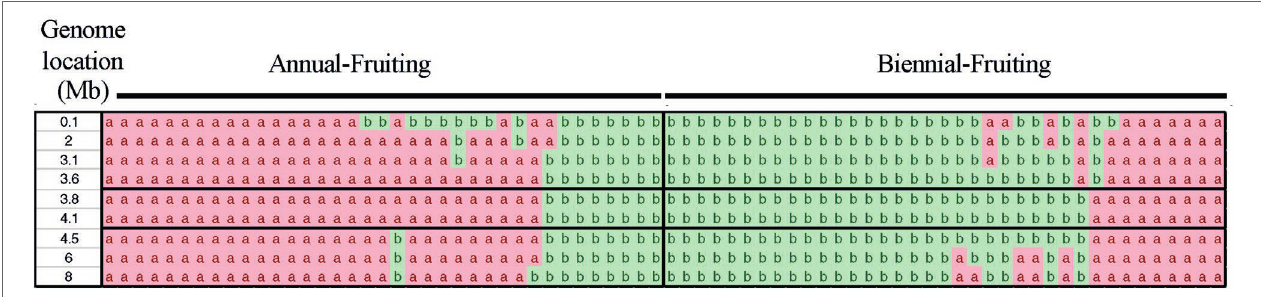
FIGURE 4 | Fine mapping the RiAF4 locus. A bin map was created by analyzing the genotypes of individuals over small genomic regions located within 0–8 Mb of LG4. Each column represents genotypic data from a single individual, either Annual-Fruiting (AF) or Biennial-Fruiting (BF). The allele of single-nucleotide polymorphisms (SNPs) in the genomic region of LG4 listed in the first column is indicated as a or b. The “a” allele (in pink) and “b” allele (in green) are linked to AF and BF, respectively. Recombination breakpoints are visible as a change in color and narrow the RiAF4 locus to the region located between 3.6 and 4.1Mb indicated by black horizontal lines.